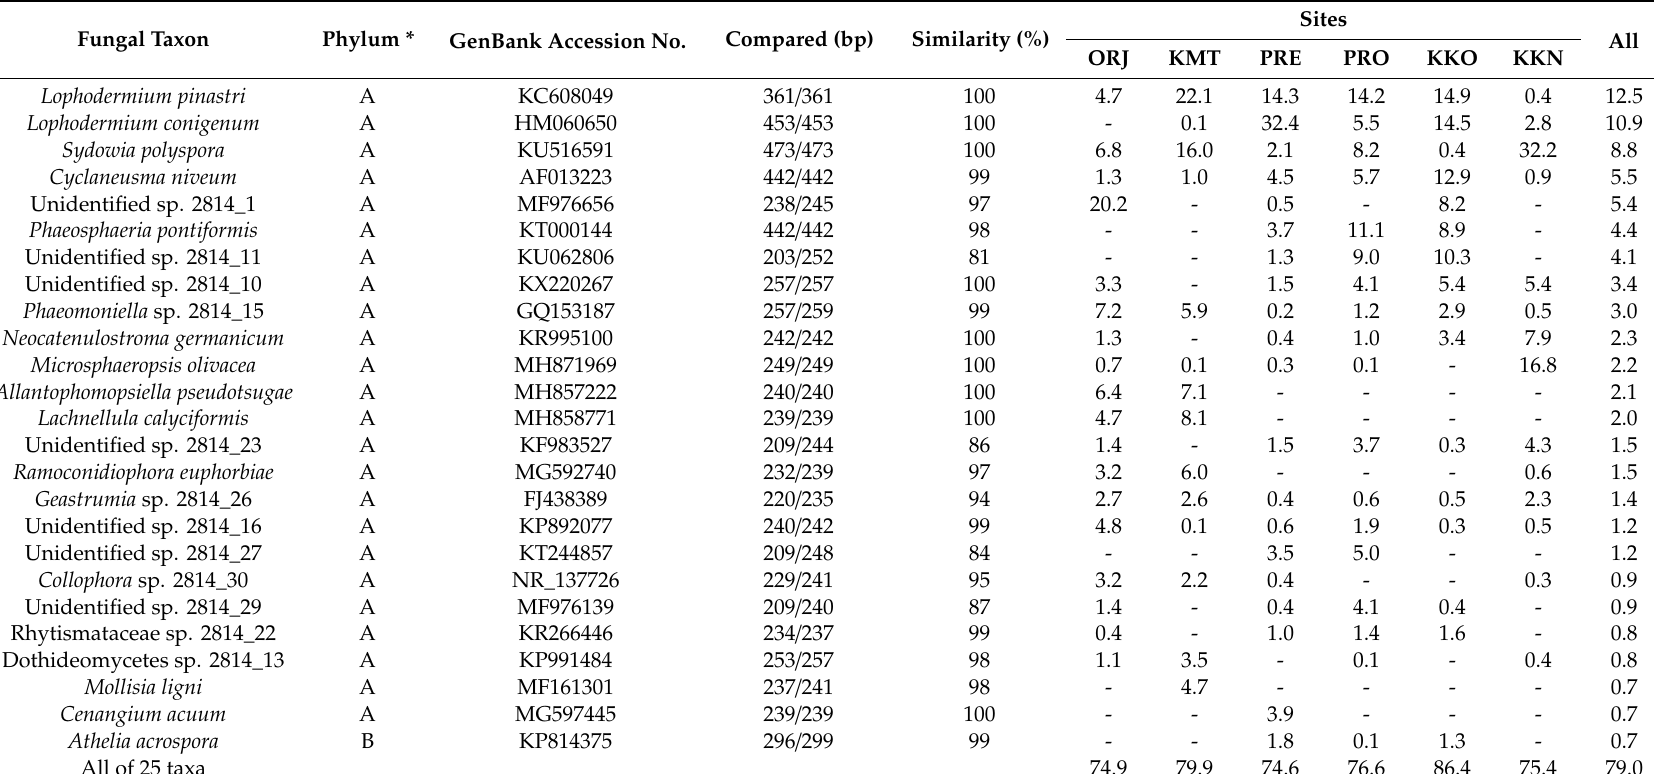
Table 3. Relative abundance of the 25 most common fungal taxa detected in needles of Pinus heldreichii at six sites in Montenegro. Sites are as in Table 1. Fungal Taxon Phylum *